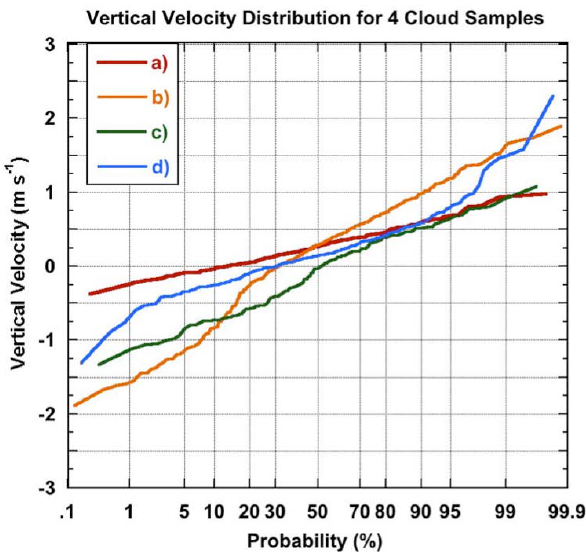
Fig. 11. Probability plot of vertical velocity (1Hz) measured along the flight track for in-cloud samples (a) through (d) shown in Fig. 10.